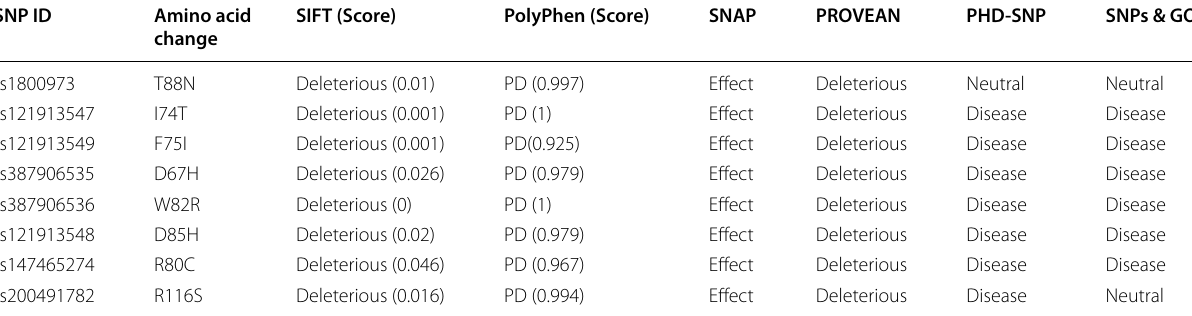
Table 1 Analysis of deleterious missense nsSNPs by various bioinformatics tools